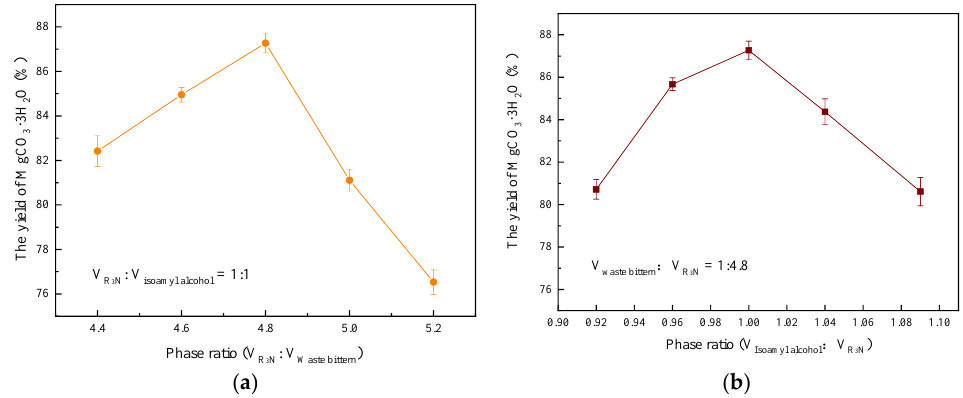
Figure 2. Effect of phase ratio of reactants on the yield of MgCO 3 · 3H 2 O at reaction time = 7 h, stirring speed = 600 rpm, and reaction temperature = 313.15 K: ( a ) the phase ratio between R 3 N and water bittern; ( b ) the phase ratio between isoamyl alcohol and R 3